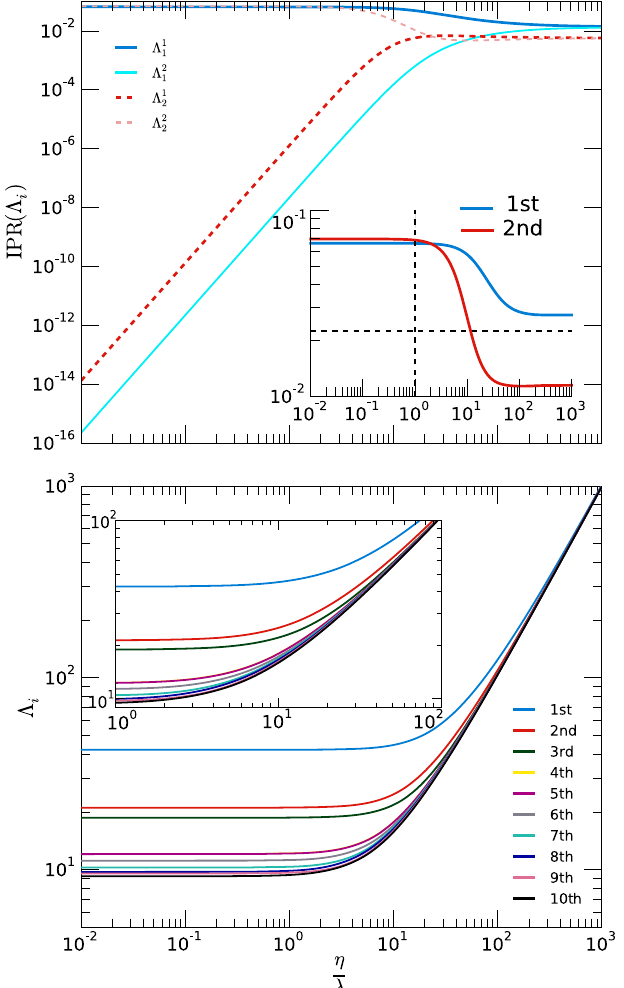
FIG. 4. Spectral properties of the tensor R ð λ ; η Þ as a function of the ratio η = λ for a multiplex with two layers, the first with γ ≈ 2 . 2 and the second with γ ≈ 2 . 8 . Both have h k i ≈ 8 . In the top panel, we present the inverse participation ratio of the two larger eigenvalues and the individual-layer contributions, while in the bottom panel, we show the leading eigenvalues. Every curve is composed of 10 3 log spaced points, in order to have enough resolution.